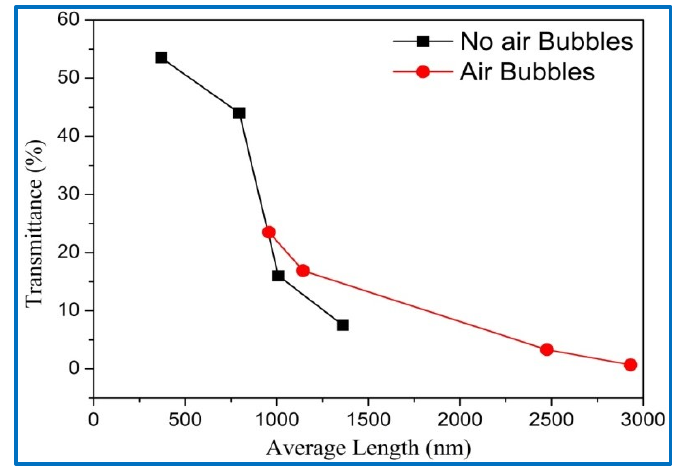
Figure 13. Optical transmittance spectrums versus average length of ZnO nanorods grown by both conventional and modified CBD methods at different precursor concentrations.